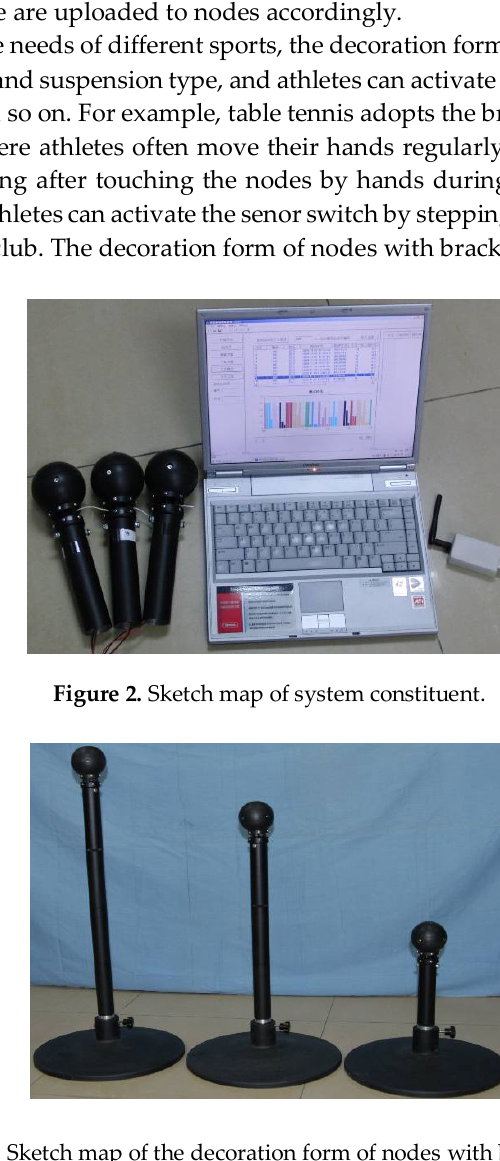
Figure 3. Sketch map of the decoration form of nodes with bracket